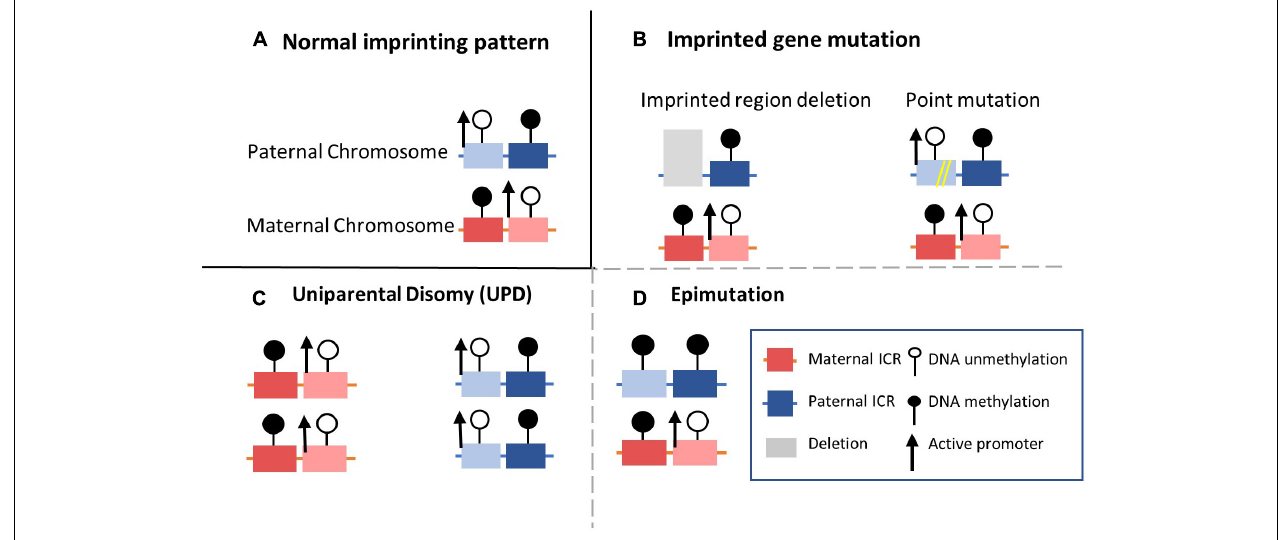
FIGURE 3 | Four common molecular mechanisms of imprinting disorders. (A) The normal state of the established DMR methylation pattern on the maternal and paternal alleles. (B) Imprinting disorder can be caused by copy number variations with imprinted cluster located such as duplication or deletion. Point mutations (single nucleotide polymorphisms) occurring in imprinted genes could also influence normal functions. (C) Both alleles are inherited from same parent-of-origin. In the case shown here, for example, maternally inherited alleles are duplicated without paternal allele participation. (D) Epimutations of DNA modification condition can disturb normal imprinting pattern without alterations in DNA sequences of the imprinted region. For example, DNA methylation of the imprinted gene on paternal allele are hypermethylated and silenced on both alleles.